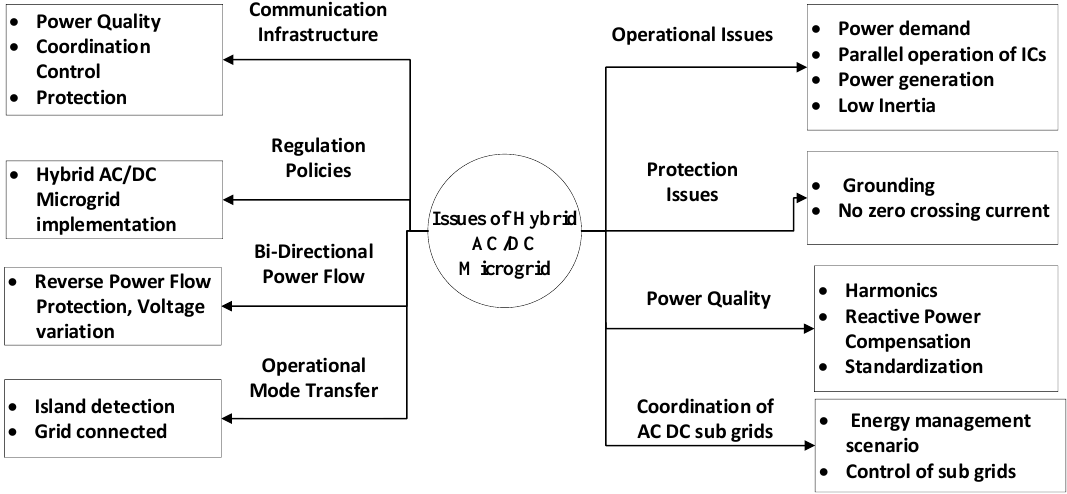
Figure 2. Challenges of hybrid AC/DC microgrid.